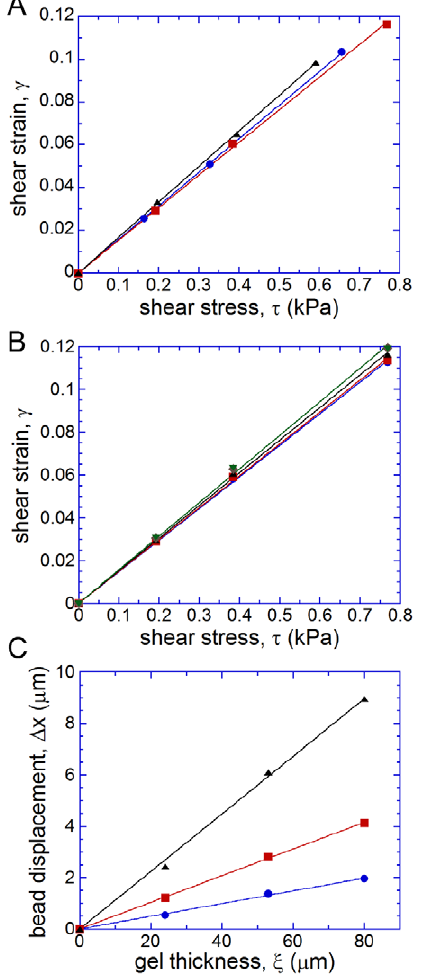
Figure 2. Measurements of gel elastic moduli using the microfluidic device. (a) Gel shear strain, c , as a function of the hydrodynamic shear stress, t , in the internal regions of the test channels 1 (blue circles), 2 (red squares), and 3 (black triangles), for a 70 m m layer of gel with B/C=45. The data points for the three test channels are fitted with zero-crossing straight lines of matching colors. (b) c as a function of t measured in test channel 2 in five microfluidic devices bonded to gel layers on five separate cover glasses. Gel thicknesses were 58, 58, 64, 65, and 66 m m, all prepared using the same pre- polymer with B/C=45. Data points for different gel layers are shown by different colors and symbols (circles, squares, diamonds, and triangles) and fitted by separate zero-crossing straight lines. (c) Displacement of beads on the gel surface, D x , as a function of the gel thickness, j , measured with microfluidic chips bonded to three different gel layers in test channel 2 at pressures, D P , of 1.5 kPa (blue circles), 3 kPa (red squares), and 6 kPa (black triangles), corresponding to t ~ 0 : 059 , 0.117, and 0.243 kPa, respectively. The three dependencies are fitted with zero-crossing straight lines of matching colors. All three gel layers were prepared from the same pre-polymer with B/C=58.